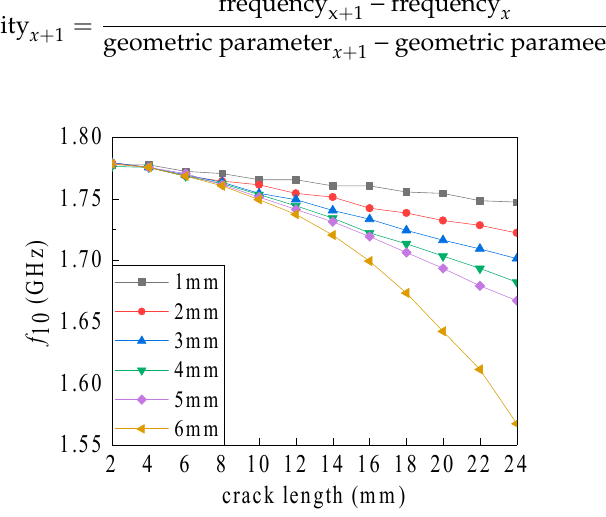
Figure 5. Dependence of the resonant frequency on the crack length associated with different crack depths. Table 2. Identification sensitivity of crack